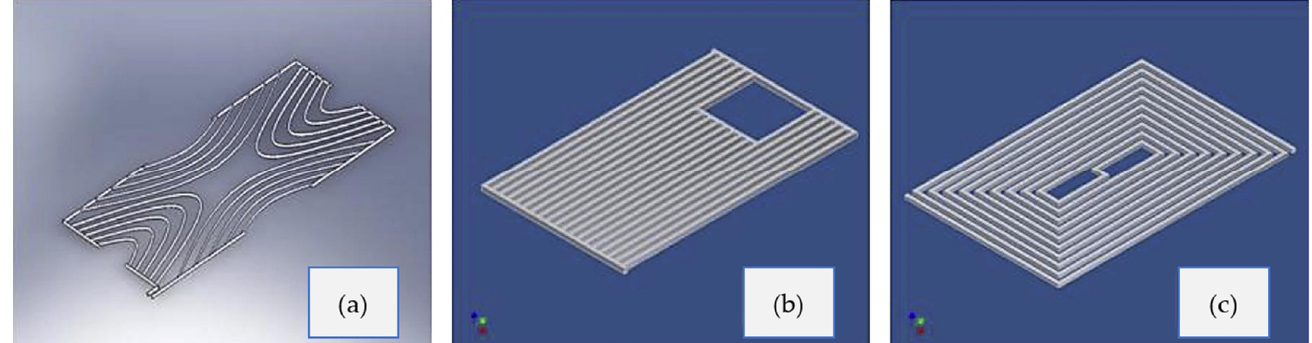
Figure 12. Several designs on sheet and tube thermal collectors; ( a ) Web flow, ( b ) direct flow, and ( c ) spiral flow. Reprinted with permission from Ref. [8]. 2014. Fudholi et al.